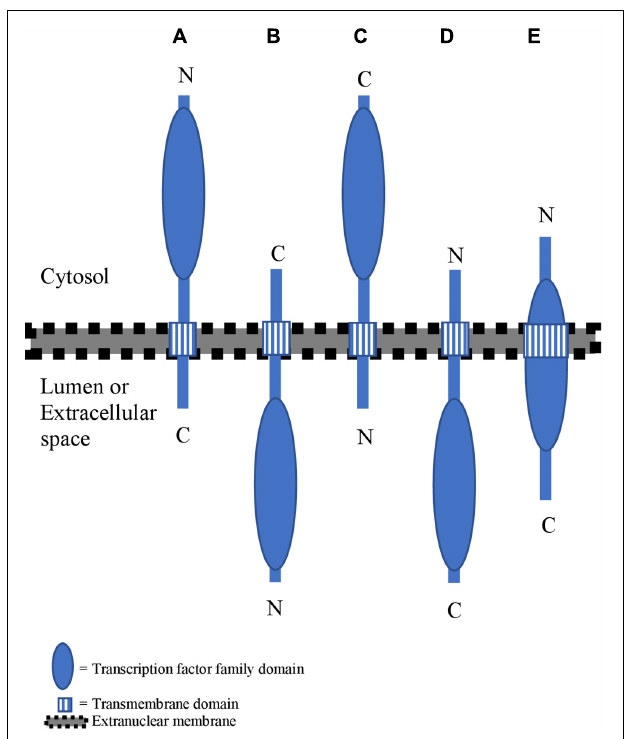
FIGURE 1 | Overview of different membrane topologies for membrane-bound TFs (MB-TFs). (A) MB-TFs with the transmembrane domain (TMD) at the C-terminal side of the transcription factor family domain (TFFD) and a type-II membrane topology. (B) MB-TFs with the TMD at the C-terminal side of TFFD and a type-I membrane topology. (C) MB-TFs with the TMD at the N-terminal side of TFFD and a type-I membrane topology. (D) MB- TFs with the TMD at the N-terminal side of TFFD and a type-II membrane topology. (E) MB-TFs with the TMD overlapping with the